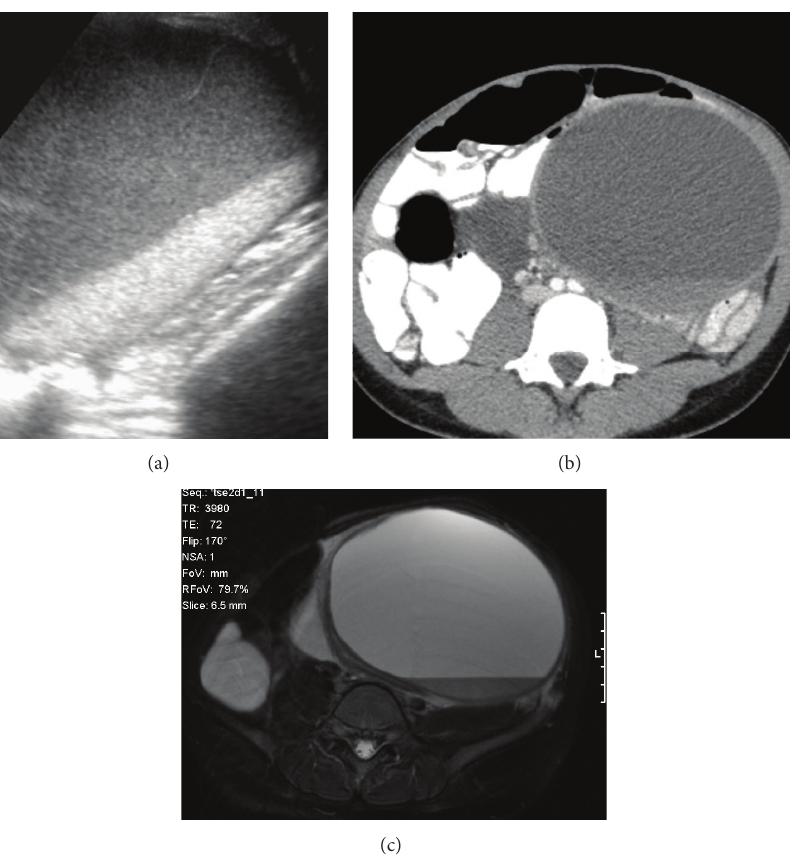
Figure 4: (a) Ultrasound demonstrating a complex cystic mass in the left adnexa with a blood fluid level and internal septations. (b) Axial CT demonstrating a large multiloculated left lower abdominal cystic “mass” with a blood fluid level. (c) Axial T2 MR image demonstrating a blood fluid level in a cystic “mass” in the left quadrant. There is also an additional component in the right lower